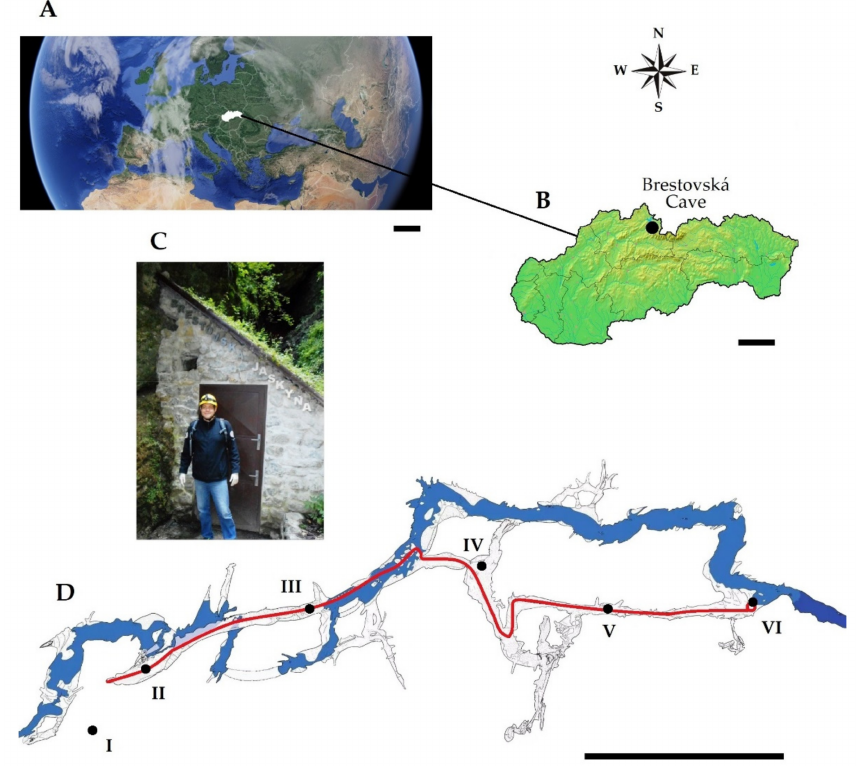
Figure 1. Geographic location of Slovakia ( A ) and the Brestovsk á Cave ( B ). Entry and exit from the cave ( C ) and underground corridors with marked sampling locations ( D ) on the tourist route (red line): location I outside the cave, and locations II to VI inside the cave. Scale bars: A = 500 km, B = 50 km, C = 50